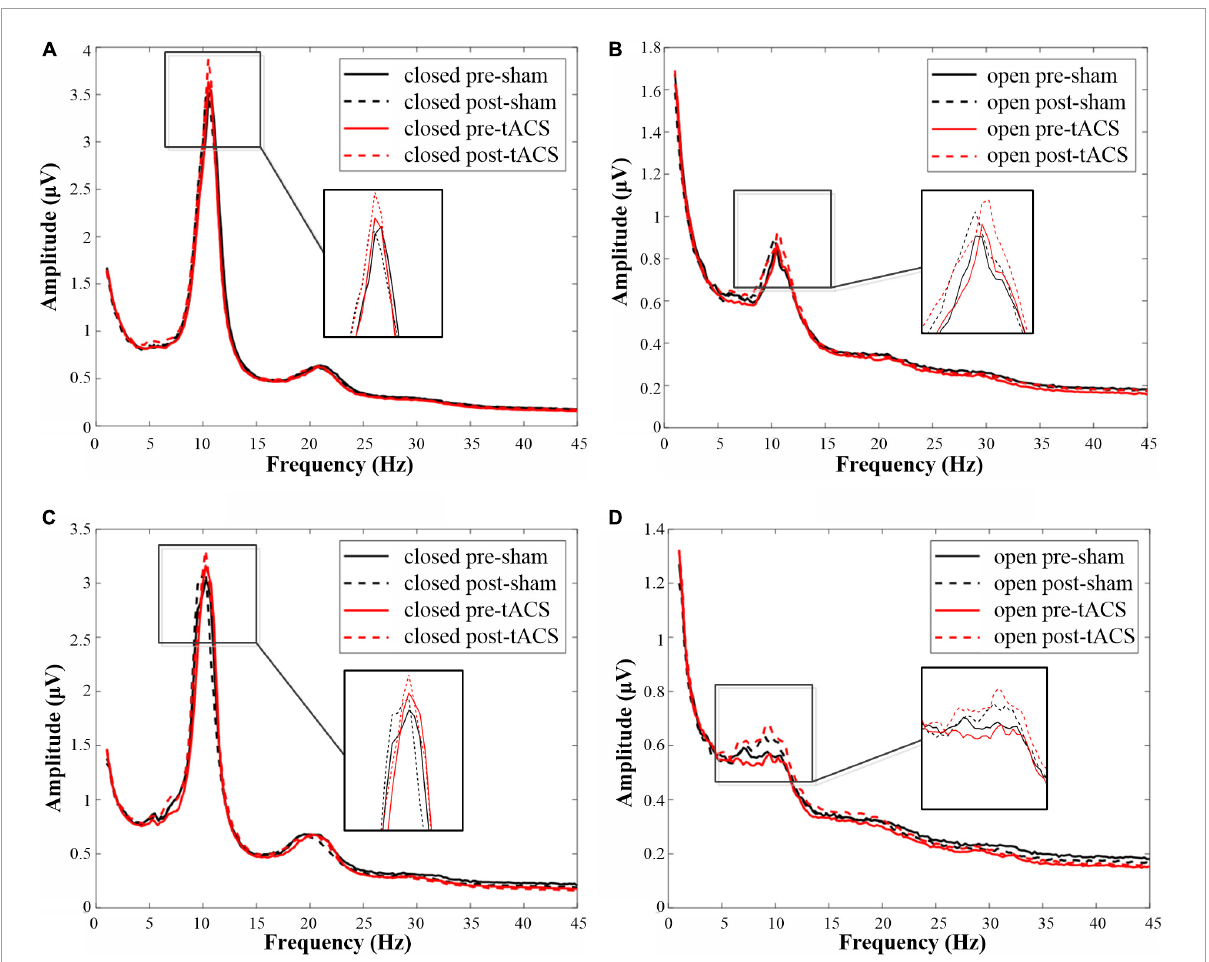
FIGURE4 The amplitudes in the alpha frequency band under each condition. (A) The amplitude map of 1-mA stimulation in the eyes-closed state. (B) The amplitude map of 1-mA stimulation in the eyes-open state. (C) The amplitude map of 2-mA stimulation in the eyes-closed state. (D) The amplitude map of 2-mA stimulation in the eyes-open